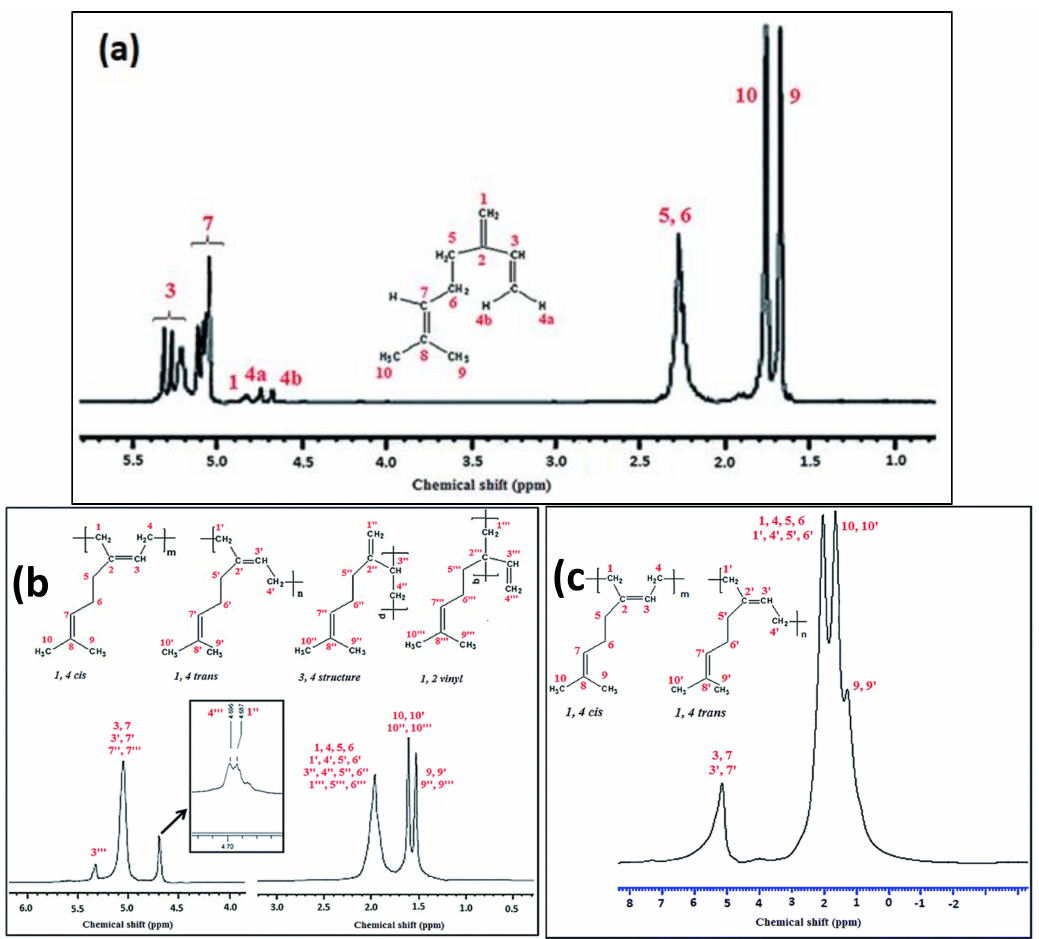
Figure 1. ( a ) 1 HNMRspectrumof β -myrcene,( b )and( c ) 1 HNMRspectraofpolymyrcene(persulfateandredox initiated). (Reproduced from Reference 19, with permission from The Royal Society of